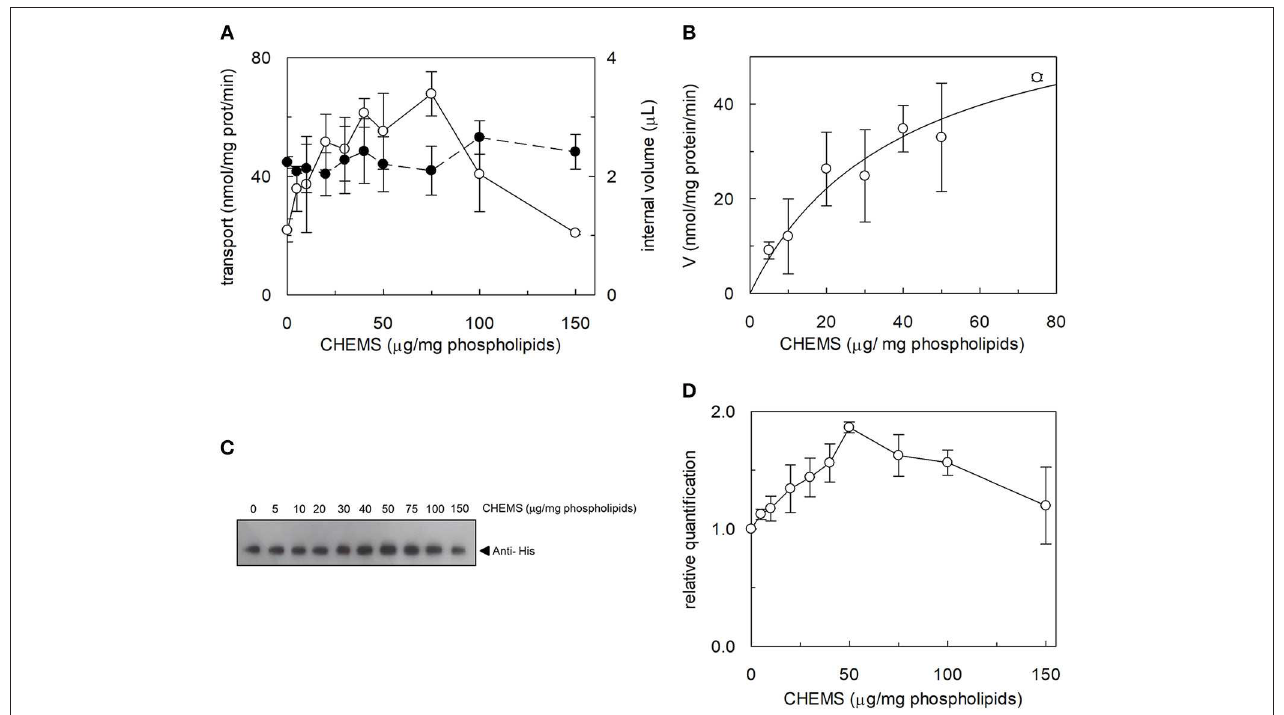
FIGURE 1 | Effect of cholesterol on hASCT2 reconstitution in proteoliposomes. (A) Purified WT hASCT2 was reconstituted in proteoliposomes prepared with the indicated amounts of CHEMS per mg phospholipids as described in Materials and Methods. Transport assay was started adding 50 µ M of [ 3 H]glutamine and 50mM Na-Gluconate to proteoliposomes containing 10mM glutamine. Transport was measured in 20min, i.e., within the initial linear part of the time course. Transport rate was expressed as nmol/mg prot/min ( ◦ , left y-axis). In the right y-axis, the internal volume of proteoliposomes used for the transport assay was calculated as